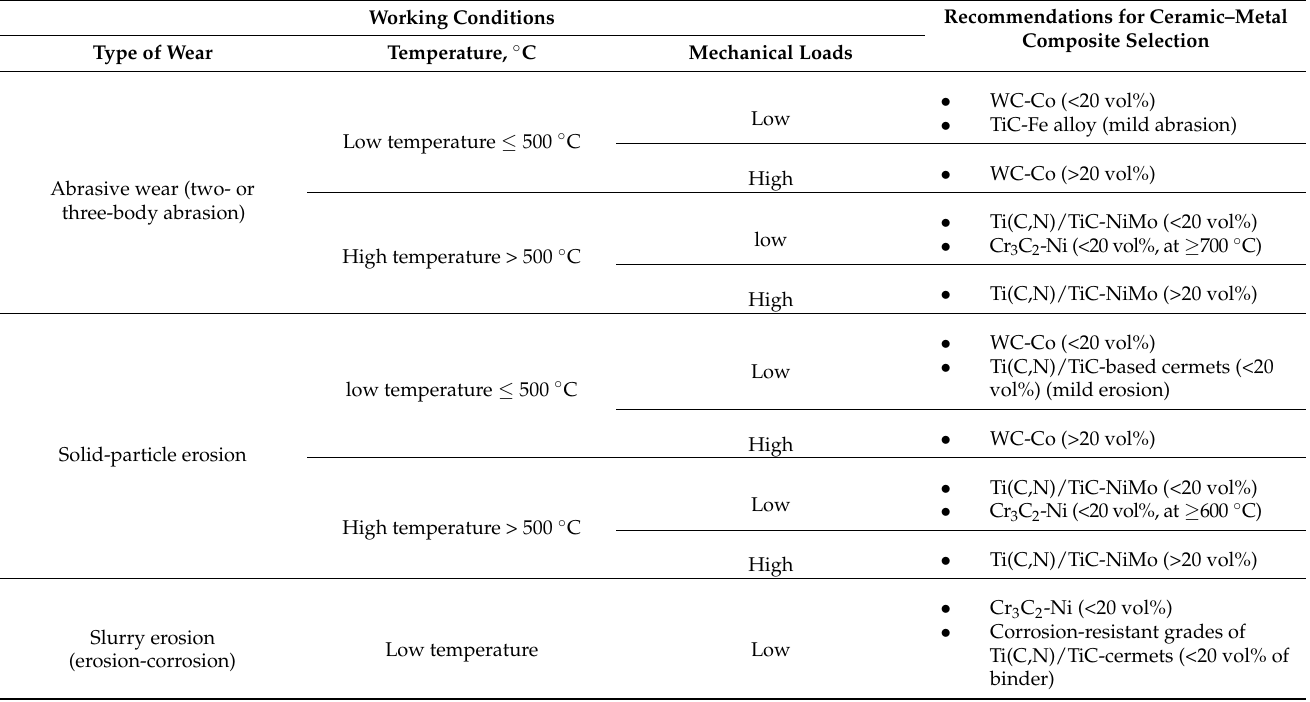
Table 6. Working conditions (abrasion or erosion, mechanical loads, temperature and corrosion) and recommendations for ceramic–metal composite